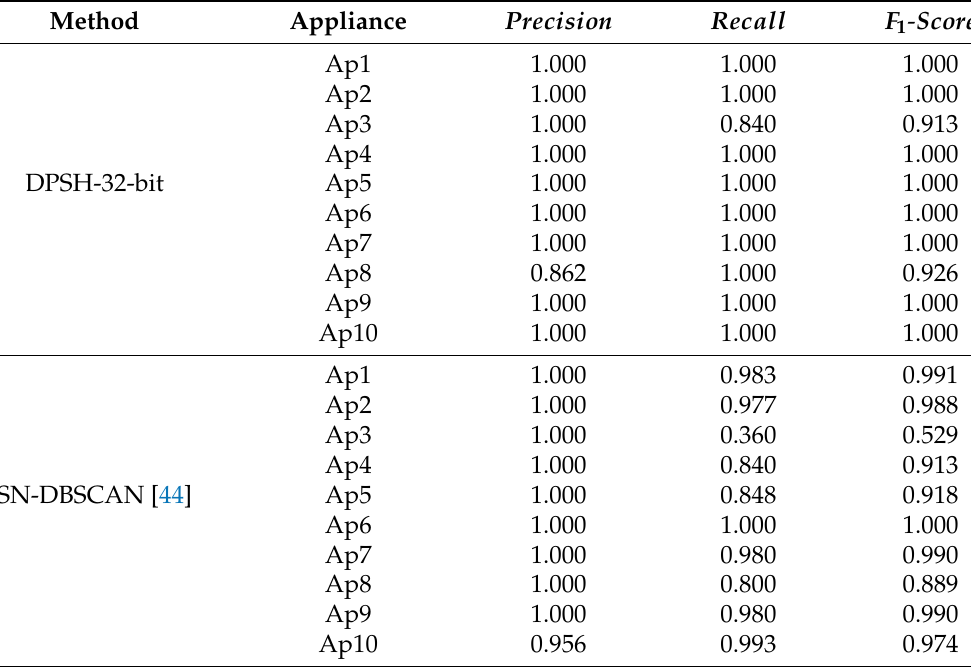
Figure 11. The performance on F 1 - score of DPSH and SN-DBSCAN algorithm with unidentified appliance. ( a ) The F 1 - score on REDD dataset. ( b ) The F 1 - score on PLAID dataset. Table 7. The disaggregation performance of retraining on REDD